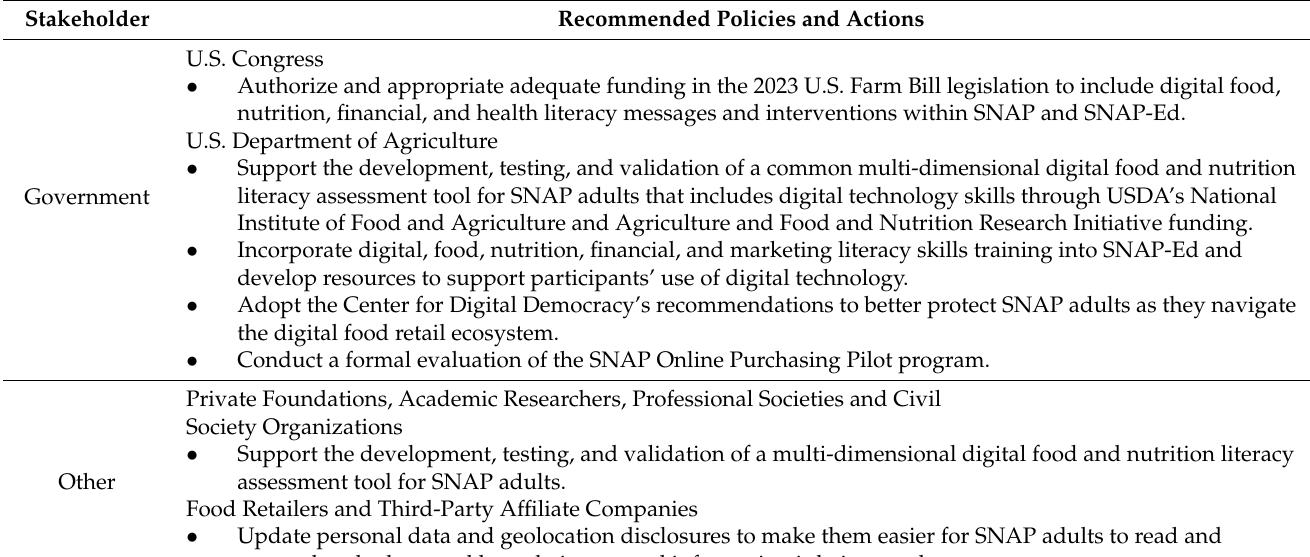
Table 5. Recommended policies and actions for U.S. Congress, USDA and other stakeholders to update SNAP and SNAP-Ed and improve SNAP adults’ digital food and nutrition literacy